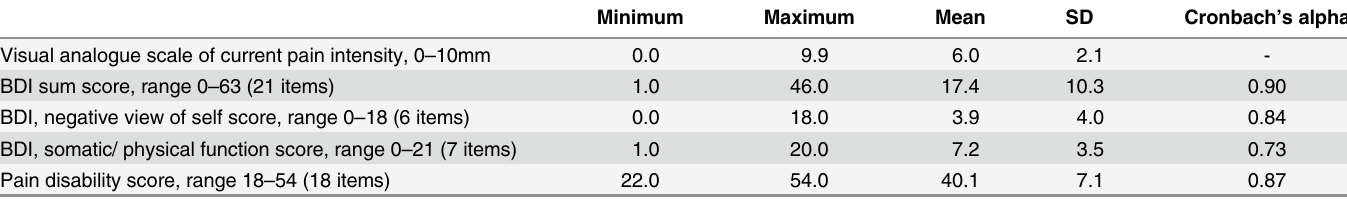
Table 1. Descriptive statistics for pain and psychological